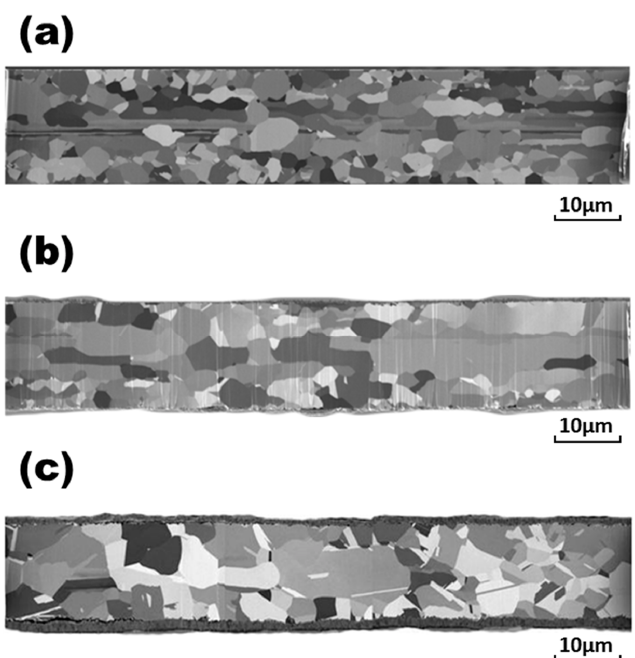
Figure 7. FIB image shows the grain structures in longitudinal cross ‐ sections of the Pd ‐ coated Cu wire after current stressing at 1.23 × 10 5 A/cm 2 for various times: ( a ) original; ( b ) 30 min; ( c ) 1 h. During electrical stressing at a current density of 1.23 × 10 5 A/cm 2 for 1 h, the central slender grains in Ag ‐ 3Pd, Ag ‐ 15Au ‐ 3Pd, and Pd ‐ coated Cu wires disappeared, and the equiaxial grains were redistributed throughout the wires, as shown in Figures 4b, 5b and 7b. It can also be seen in Figures 4 and 7 that the equiaxial grains in the original Ag ‐ 3Pd wire grew from 6.2 μ m to 11.9 μ m. In contrast to the moderate grain growth in Ag ‐ 3Pd wire, the growth of the grains in the pure Ag, Ag ‐ 0.5Pd,